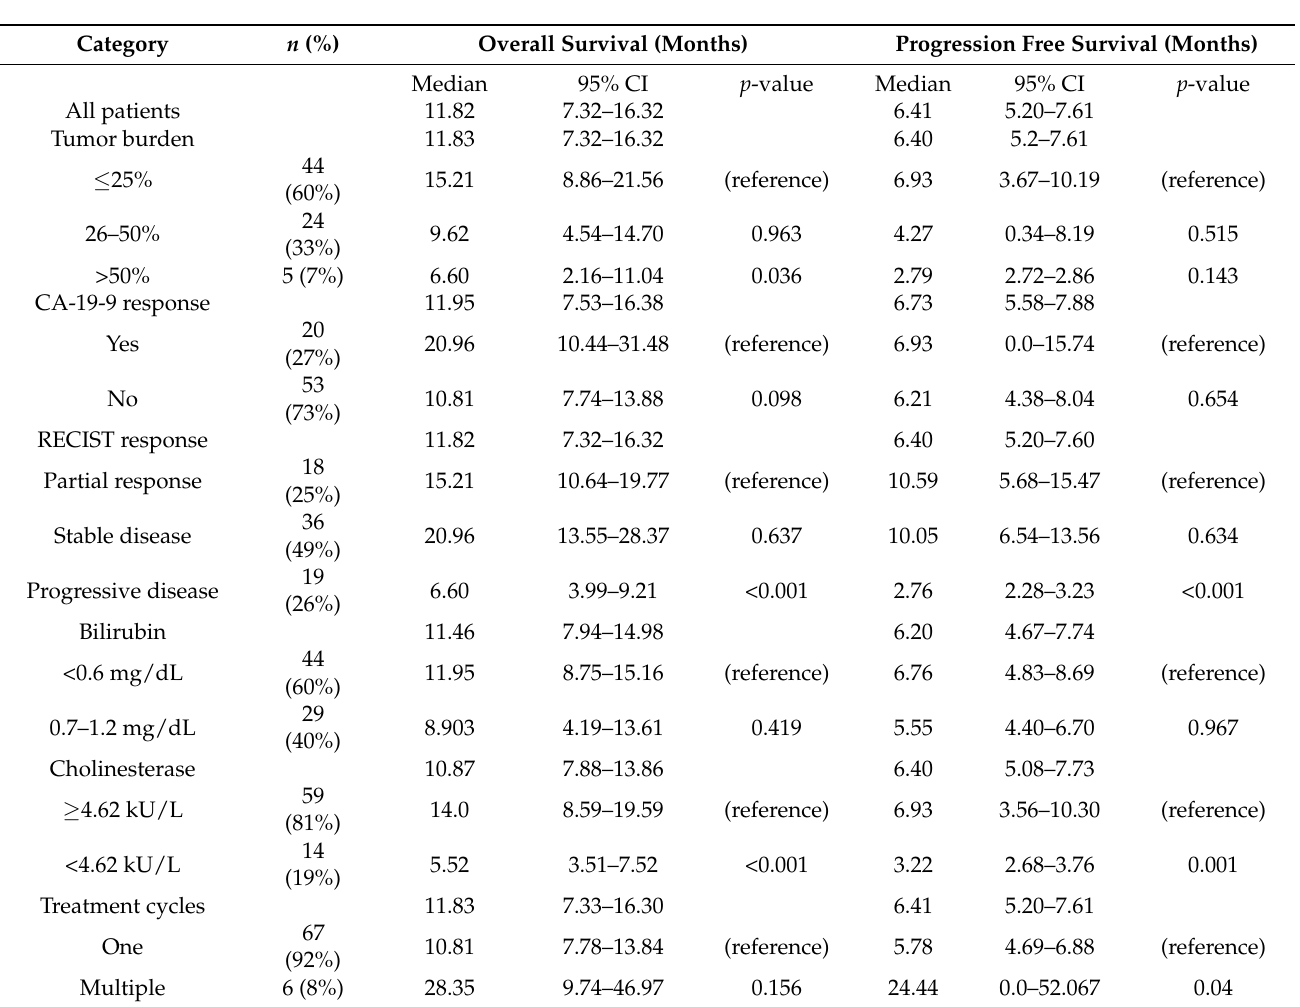
Table 3. Median OS and PFS in months.